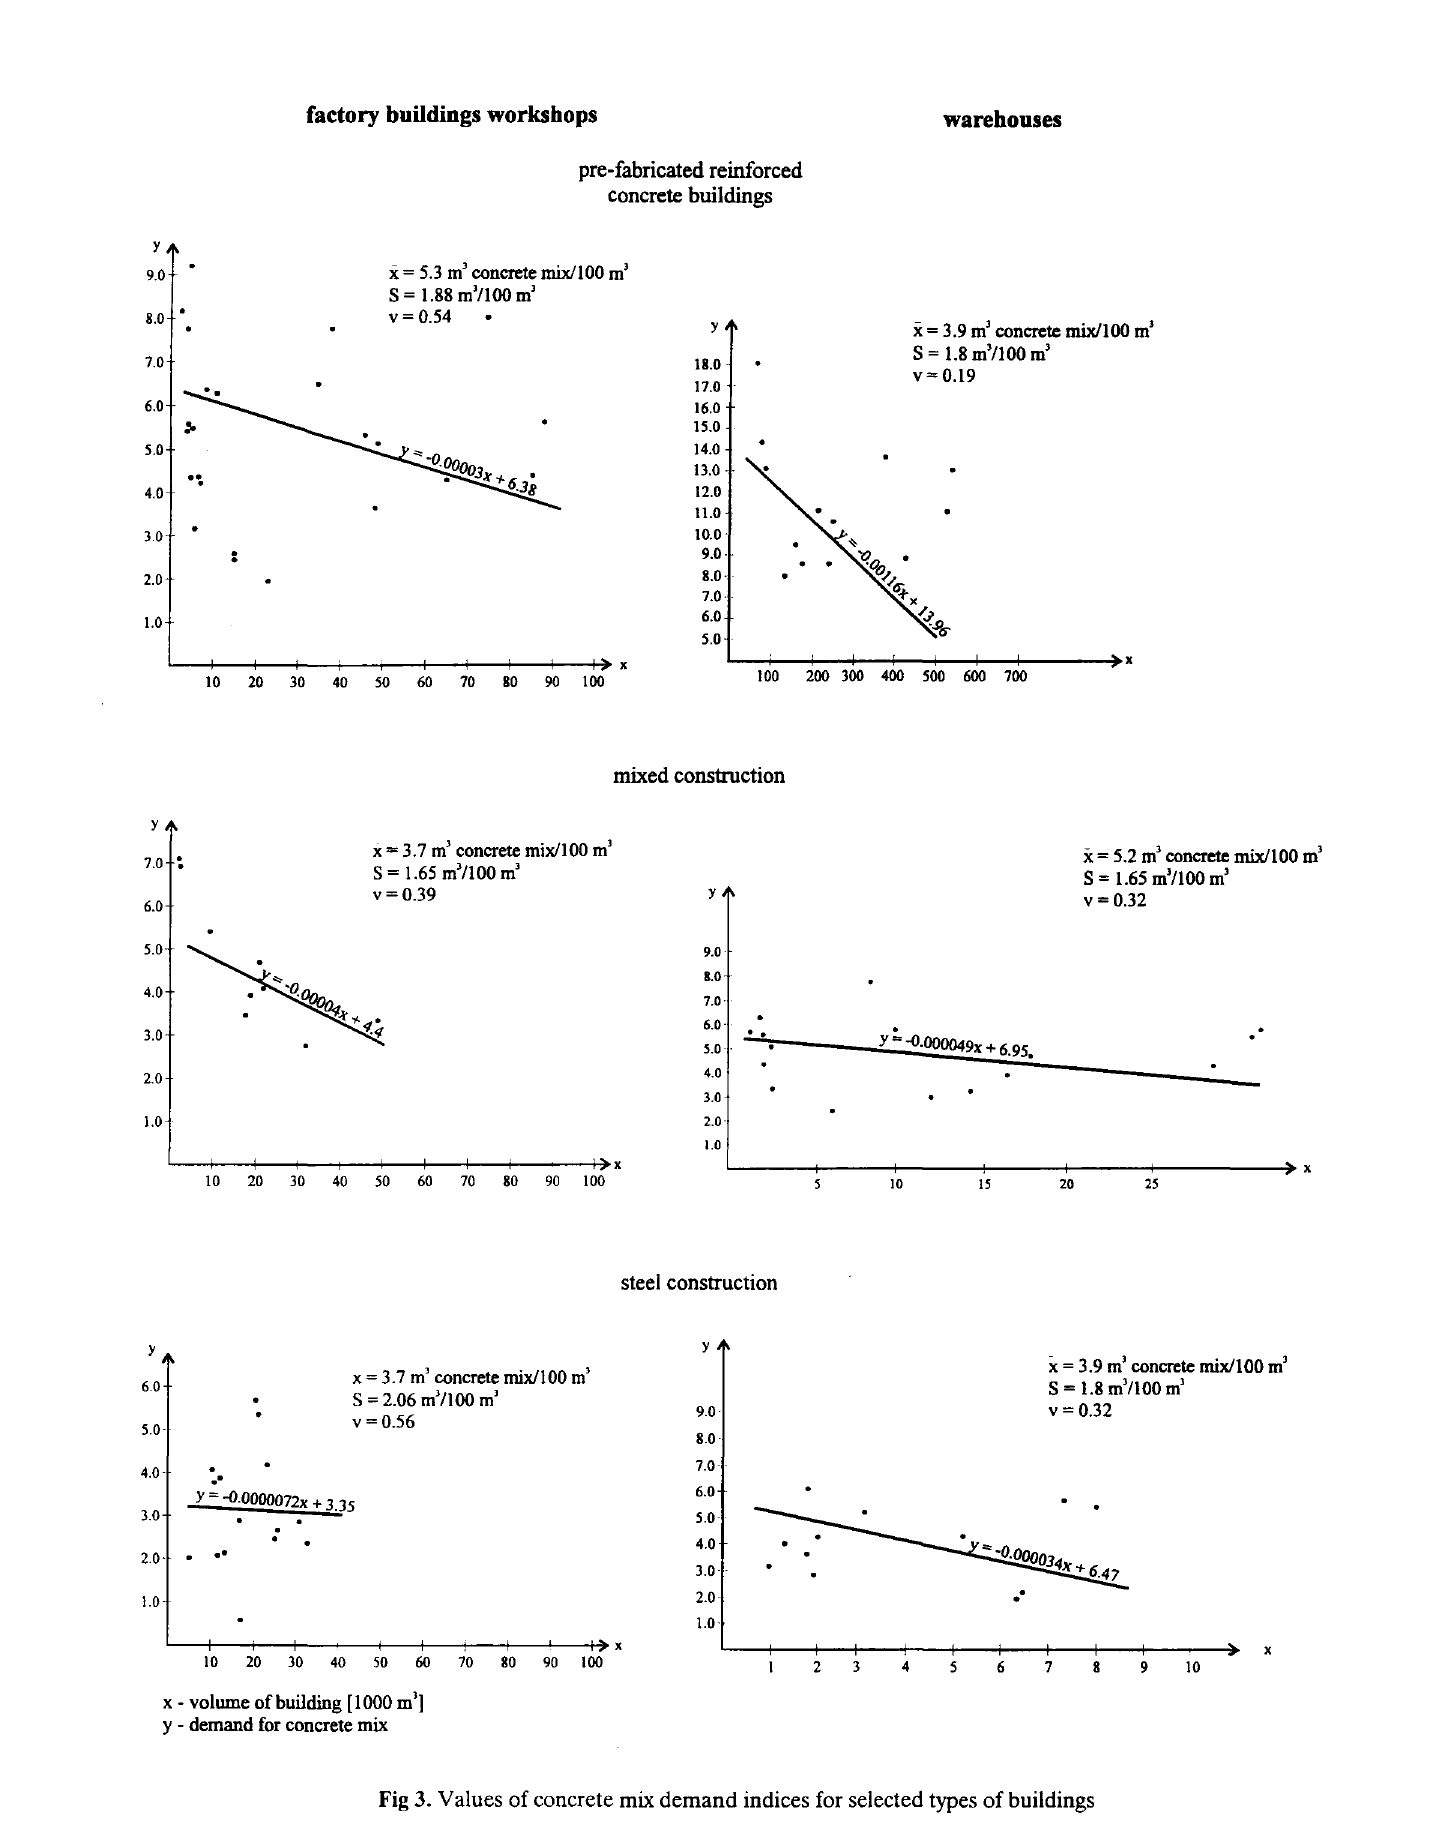
Fig 3. Values of concrete mix demand indices for selected types of